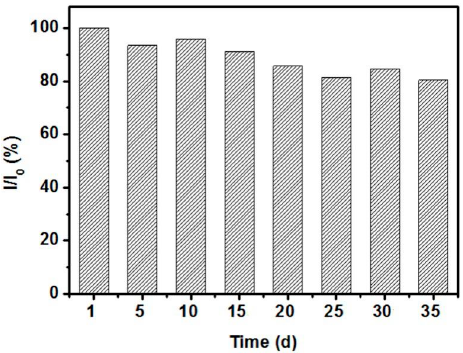
Figure 11. Stability of CeO 2 /Ni(OH) 2 /CPE electrode at ambient conditions for seven weeks using 1 mM glucose in 0.1 M NaOH solution at 0.55 V.